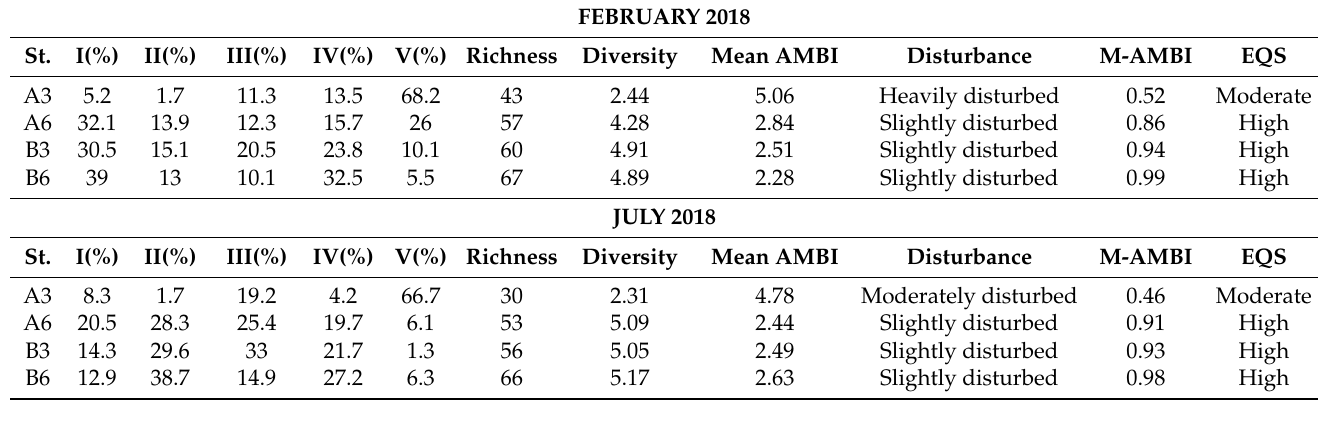
Table 7. Biotic indices values. Key: station (St.), AZTI’s Marine Biotic Index (AMBI), Multivariate- AMBI (M-AMBI), Ecological Quality Ratio (EQR).